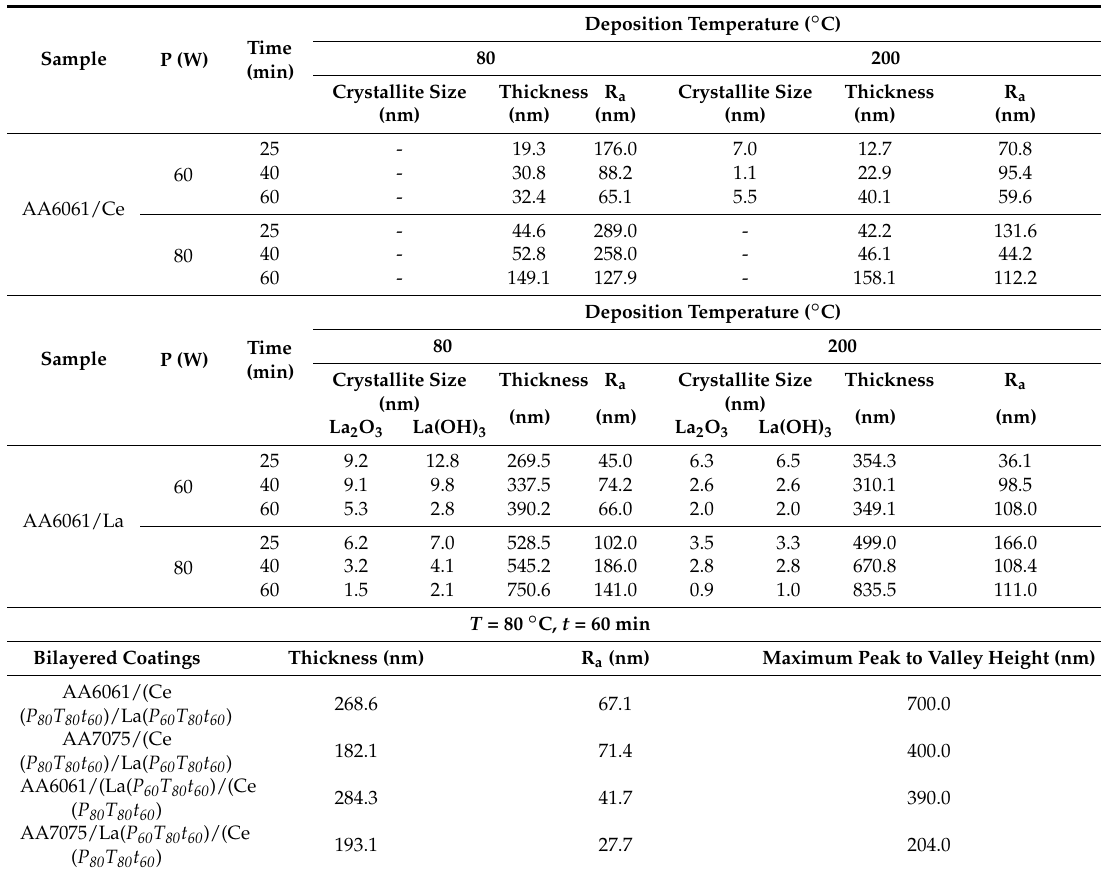
Table 1. Crystallite size, thickness and Ra of sputtered RE coatings at different experimental